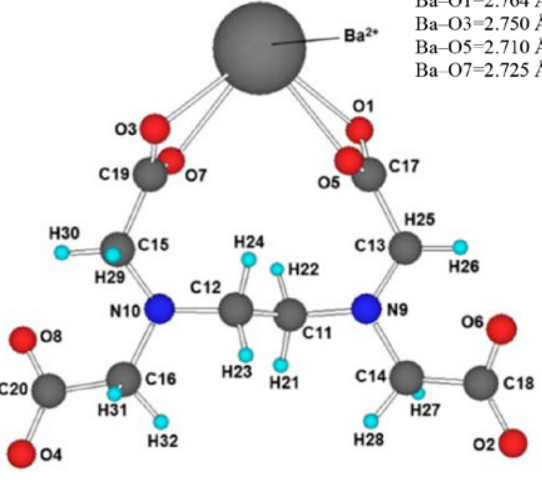
Fig. 6. Optimized structure of the most stable Ba–EDTA (P2)